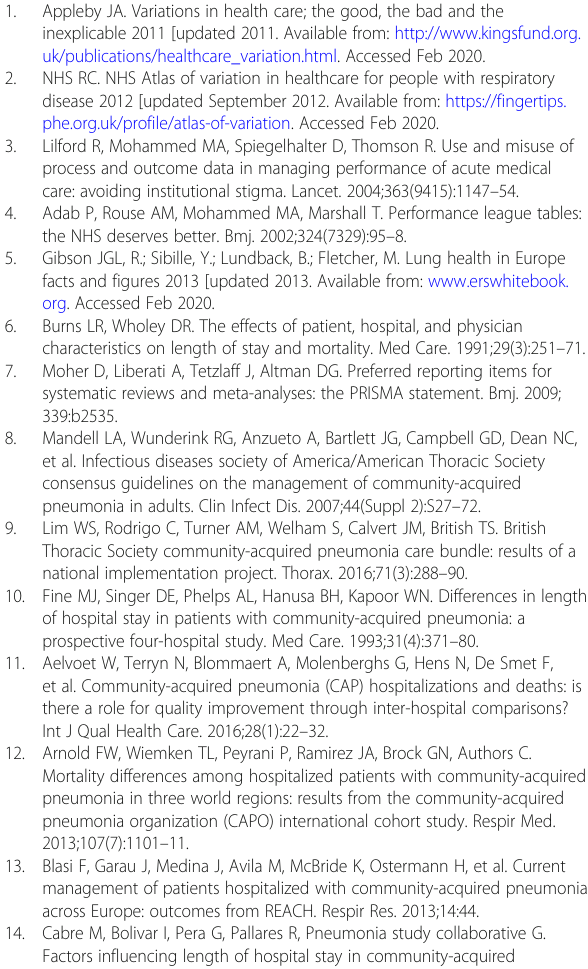
Additional file 1. Online Figure 1 Screening Consort Diagram. Table 1- Variation in Outcome Measures. Table 2 - Variation in Process of Care Measures. Additional Material Appendix